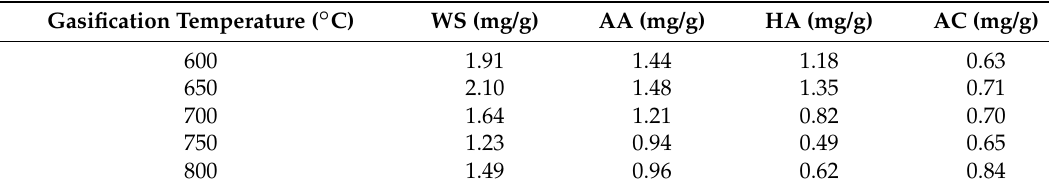
Table 6. Occurrence modes and contents of Na 1 .